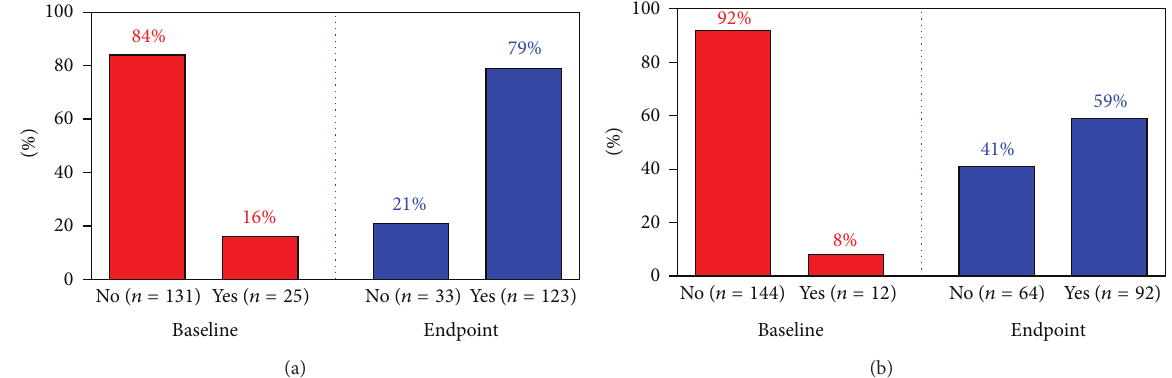
Figure 7: Patients reaching HbA 1 target of ≤ 7% (a) and ≤ 6.5% (b) at baseline and end of observation time after treatment with testosterone c undecanoate injections for up to 6 years.